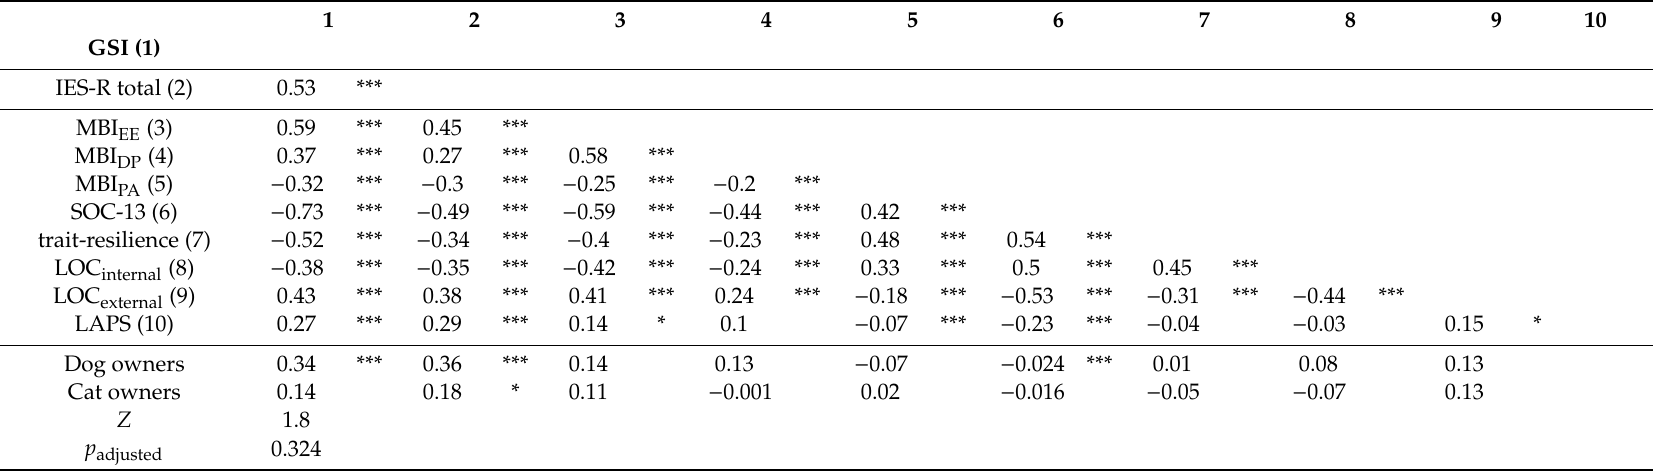
Table 2. Pearson correlations between psychopathological symptoms, health-benefitting factors and emotional attachment to the